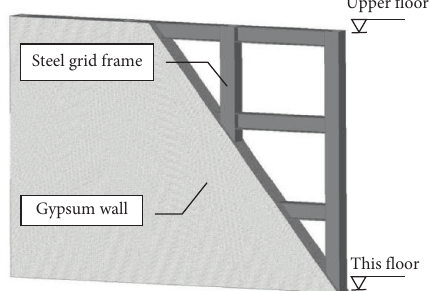
Figure 2: Two components of